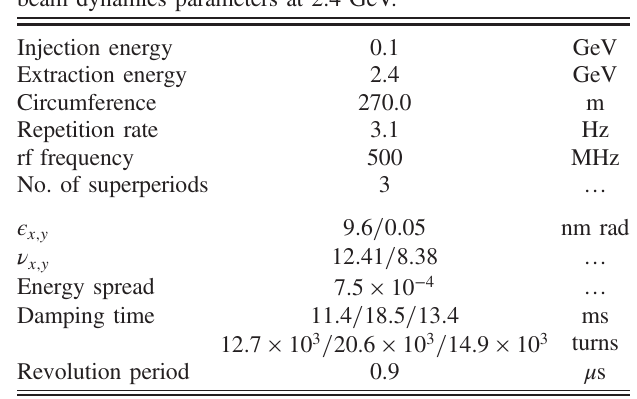
I. Physical SLS Booster specifications and